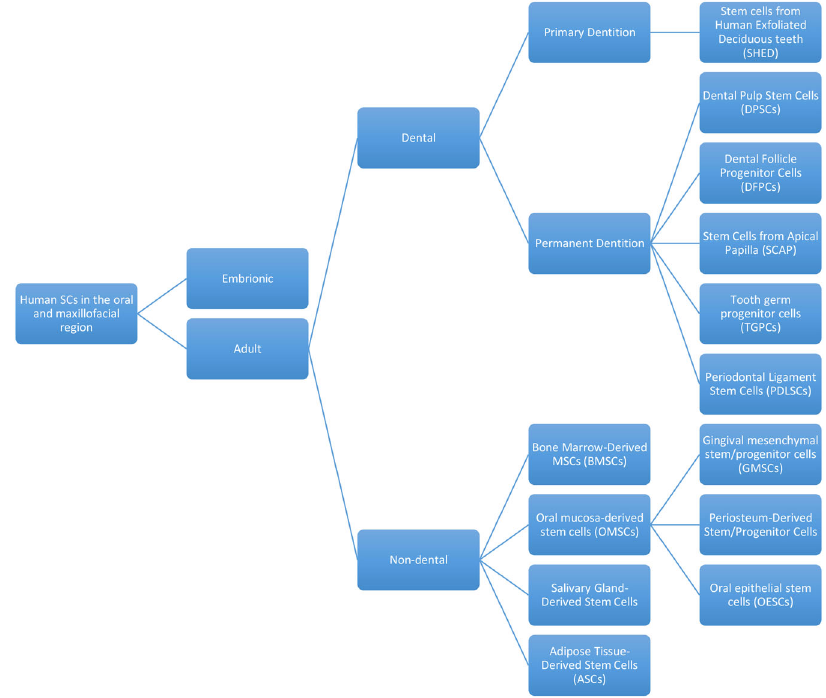
Fig. 2 Human stem cells classi fi cation in oral and maxillofacial